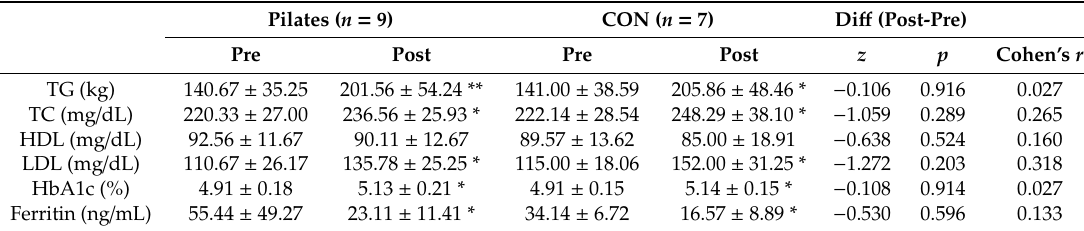
Table 3. Lipid profiles.